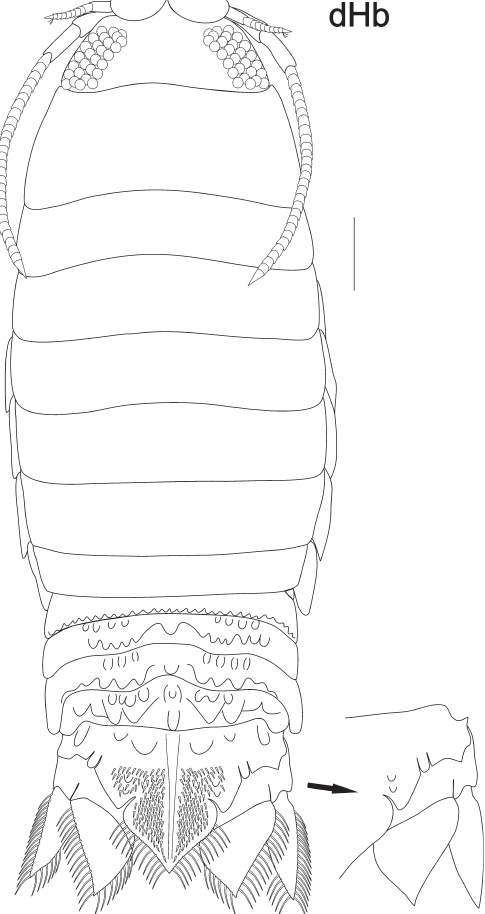
Figure 11. Excorallana richardsoni Lemos de Castro, 1960, male, 11 mm, (MOUFPE 123), habitus. Detail showing two small tubercles prior to lateral incisions. Scale= 1 mm.